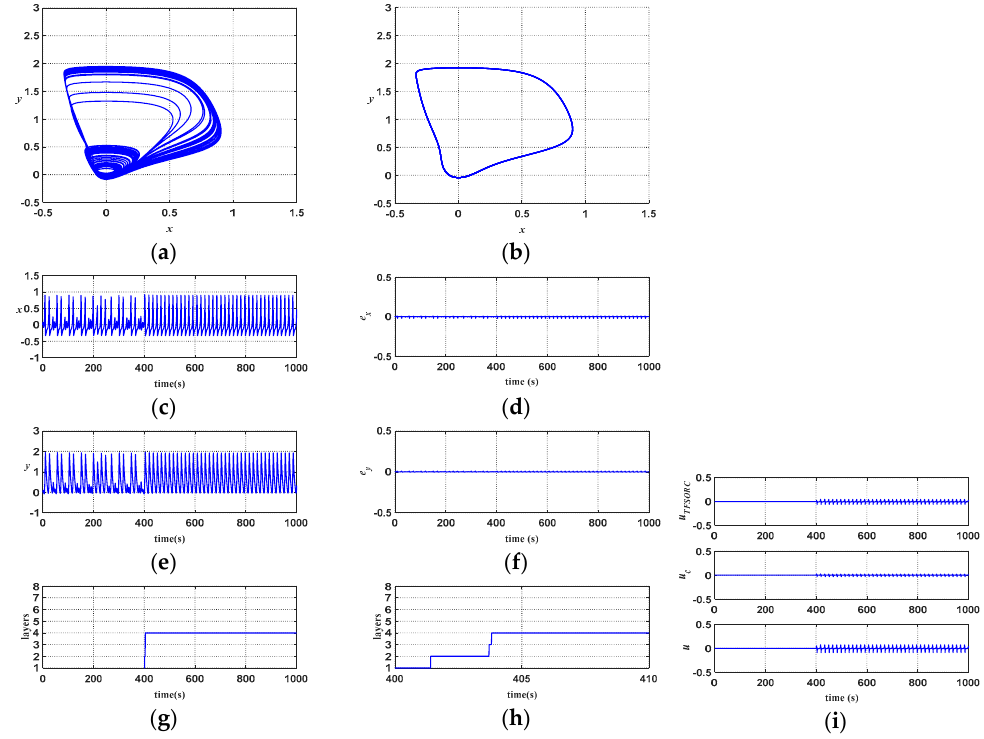
Figure 18. Simulation results of ATFSORC chaotic system stability control: ( a ) Phase diagram for uncontrolled chaotic system; ( b ) Stable phase diagram for ATFSORC; ( c ) x response for ATFSORC; ( d ) Error e x for ATFSORC; ( e ) y response for ATFSORC; ( f ) Error e y for ATFSORC; ( g ) Number of association memory layers for ATFSORC; ( h ) Number of association memory layers for ATFSORC (partial); ( i ) Control amount for ATFSORC.